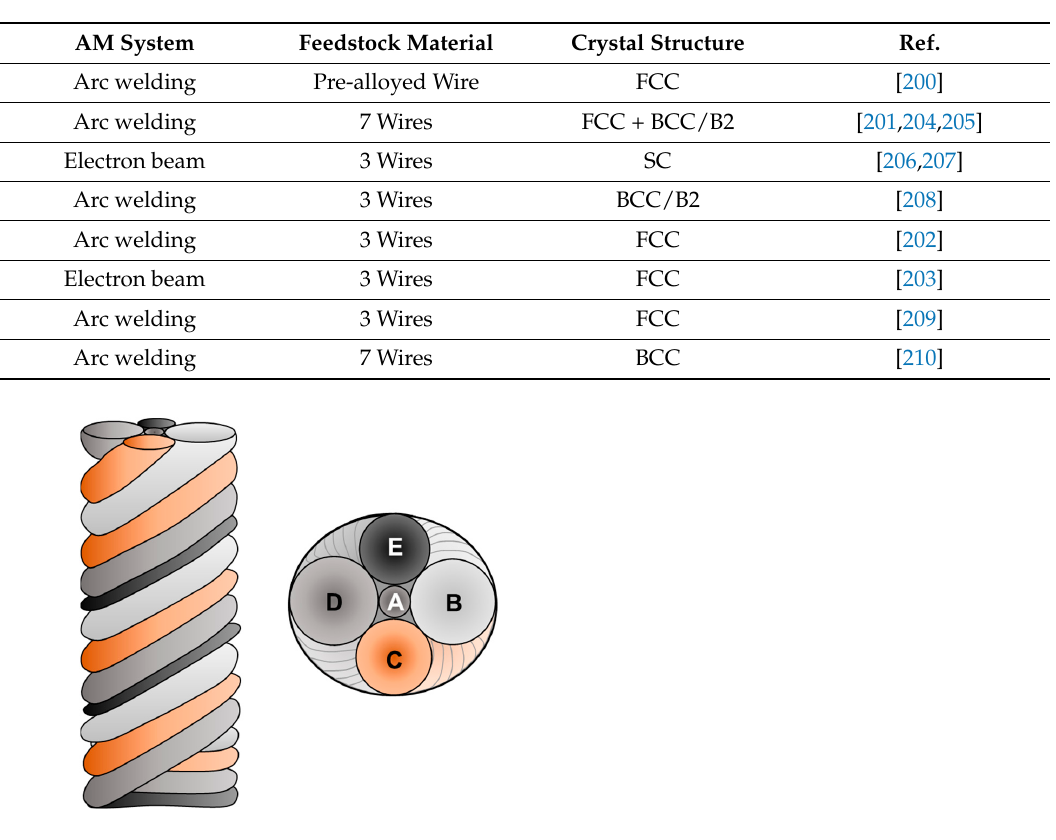
Table 6. Fabrication of HEAs by DED process using wire as feedstock material.